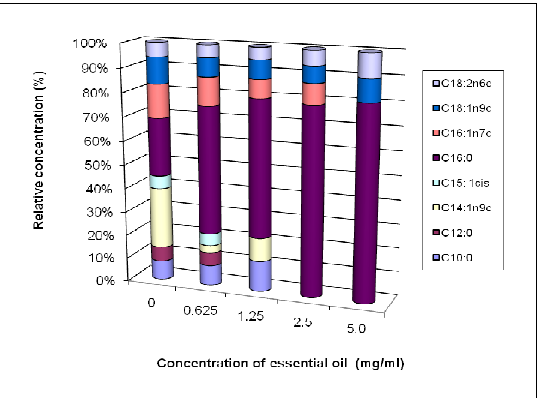
Figure 1. Effect of the essential oil of C . ambrosioides on the relative proportion of fatty acids in C. albicans fatty acid profiles.